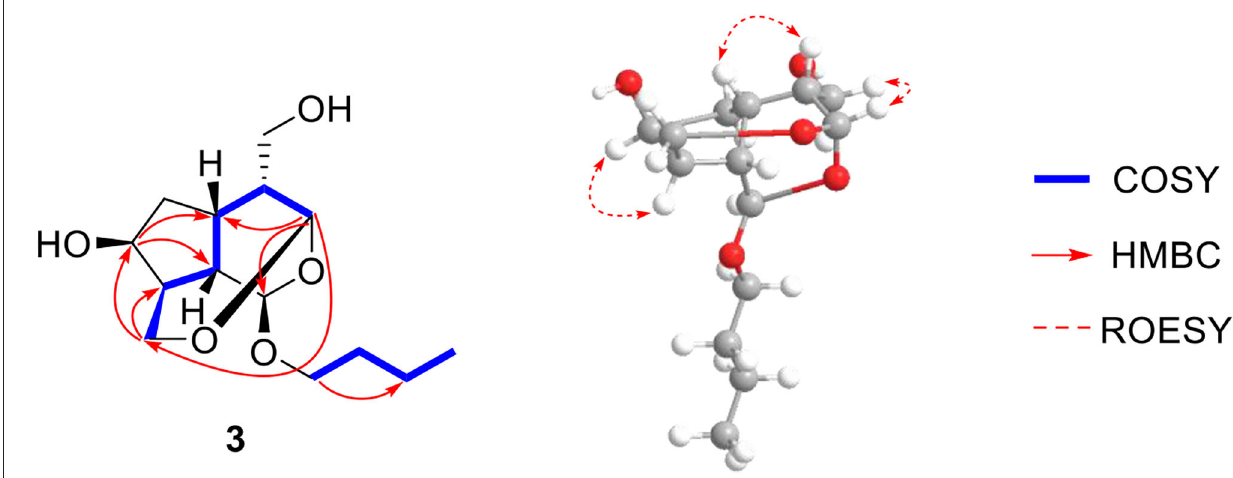
arranged at C-1 and C-11 by the correlations from δ H 5.90 (H-1) to δ C 166.4 (C-1’), and δ H 4.29 (H-1”) to δ C 69.7 (C- 11”) in HMBC spectrum ( Figure 8 ). The typical signal for β - configuration ( δ H 4.29, d, J = 7.8 Hz) of H-1” could also